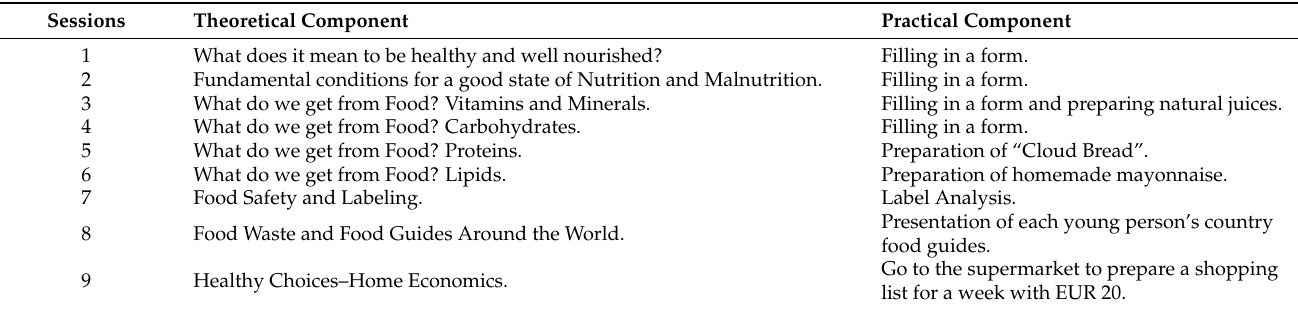
Table 1. Plan for food and nutrition education